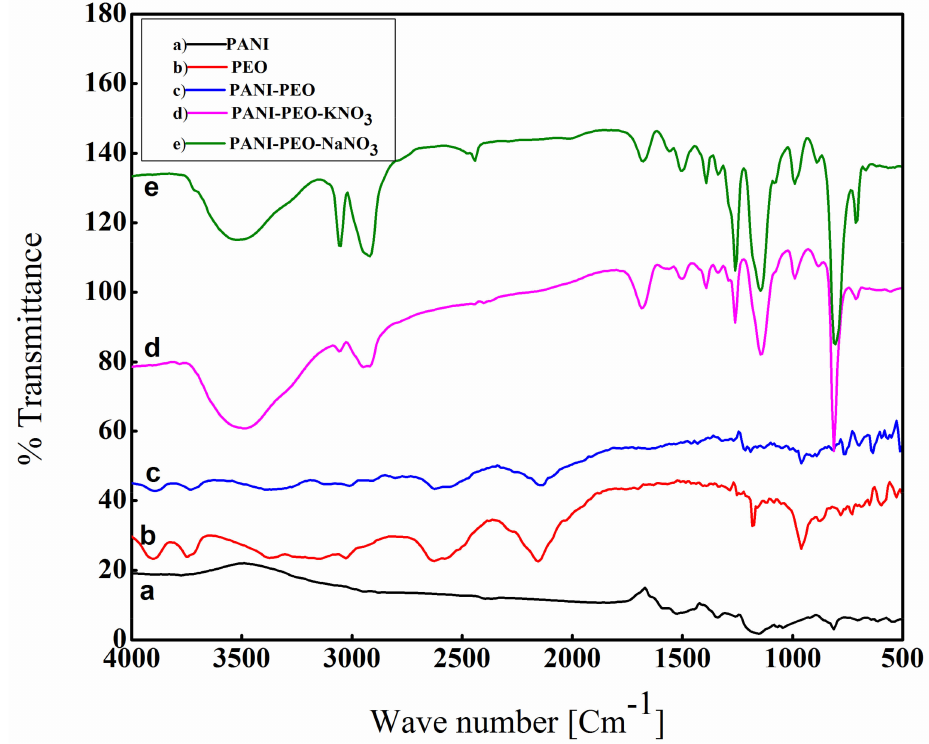
Figure 1. Spectra of ( a ) PANI ( b ) PEO ( c ) PANI-PEO ( d ) PANI-PEO-KNO 3 and ( e ) PANI-PEO-NaNO 3 . FT-IR bands of the composites of PANI-PEO with KNO 3 and NaNO 3 salts (Figure 1d,e,